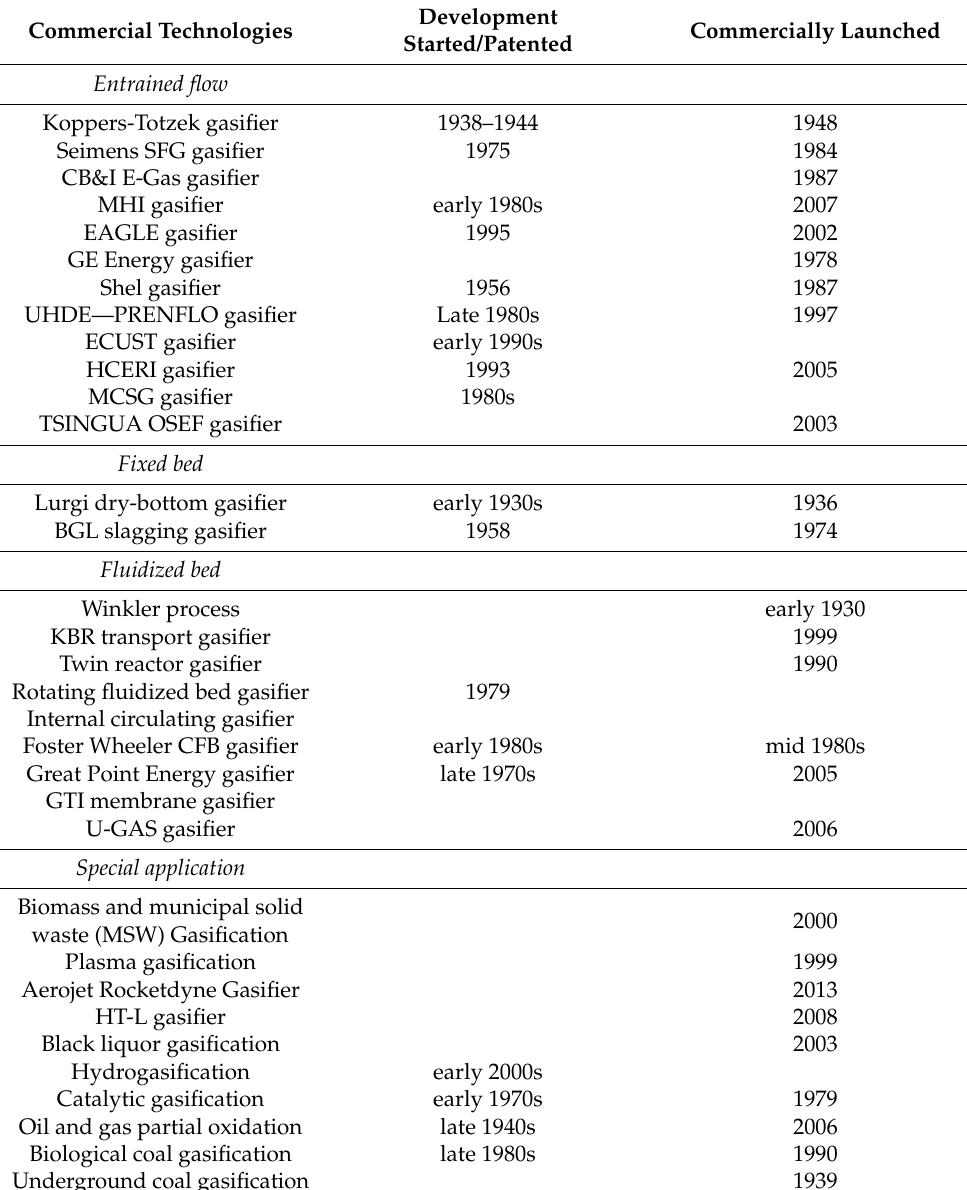
Figure 1. Gasification technologies. Table 2. Gasifier technology